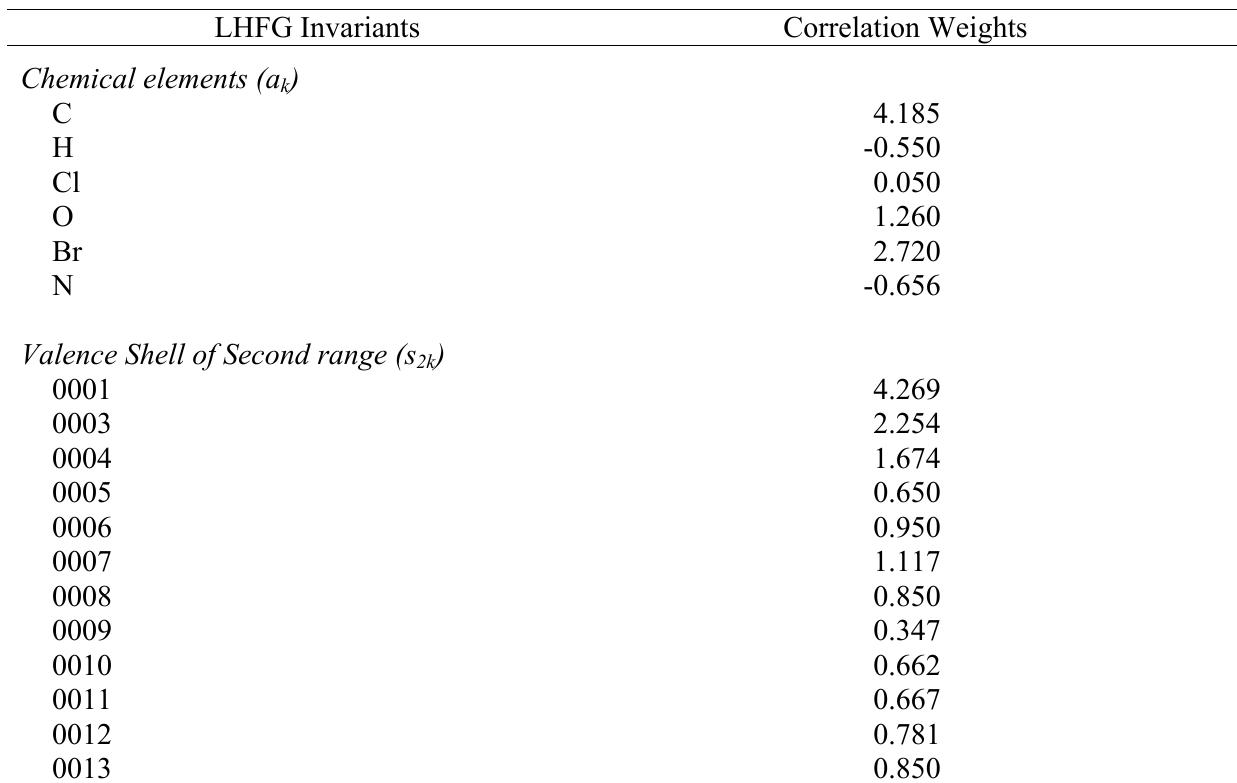
Table 3 . Correlation weights of the LHFG invariants for calculating 0 OCWLI.